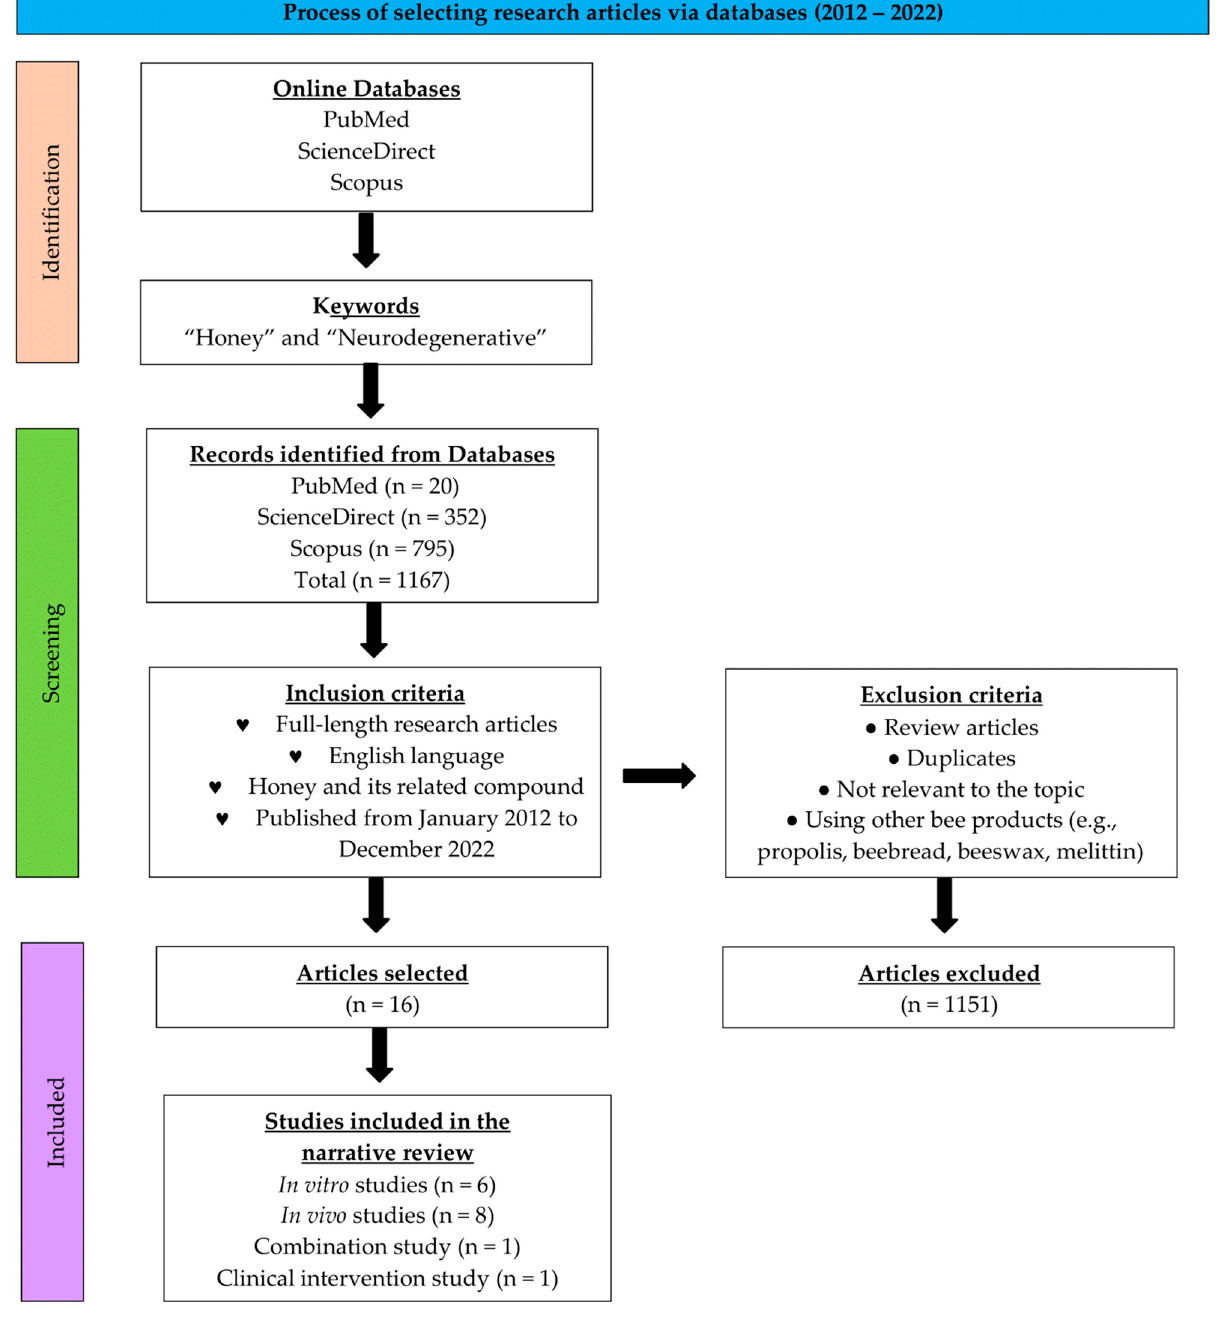
Figure 1. Flow diagram for the process of selecting research articles via online databases for the period of ten years (2012–2022). period of ten years